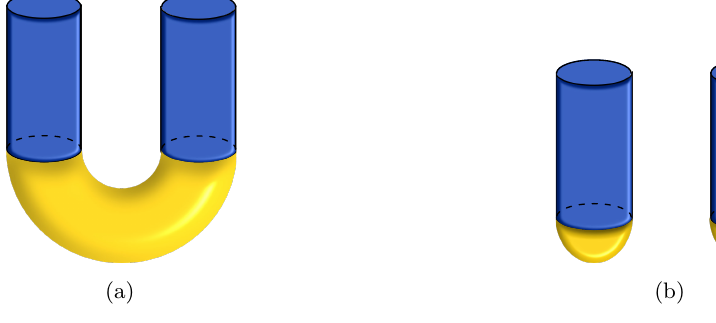
Figure 13 . TFD and Factorized Vacuum States in AdS 3 ∪ AdS 3 . Thermal AdS 3 , obtained from Euclidean AdS 3 by compactifying the global time coordinate ξ ∼ ξ + β , has the topology of a solid torus. Cutting the torus in half at ξ = 0 and ξ = β/ 2 and gluing a copy of Lorentzian AdS 3 at each prepares the TFD state in two disconnected copies of AdS 3 (left). By contrast, the factorized vacuum (right) is an unentangled state prepared by cutting EAdS 3 in half and gluing it to each